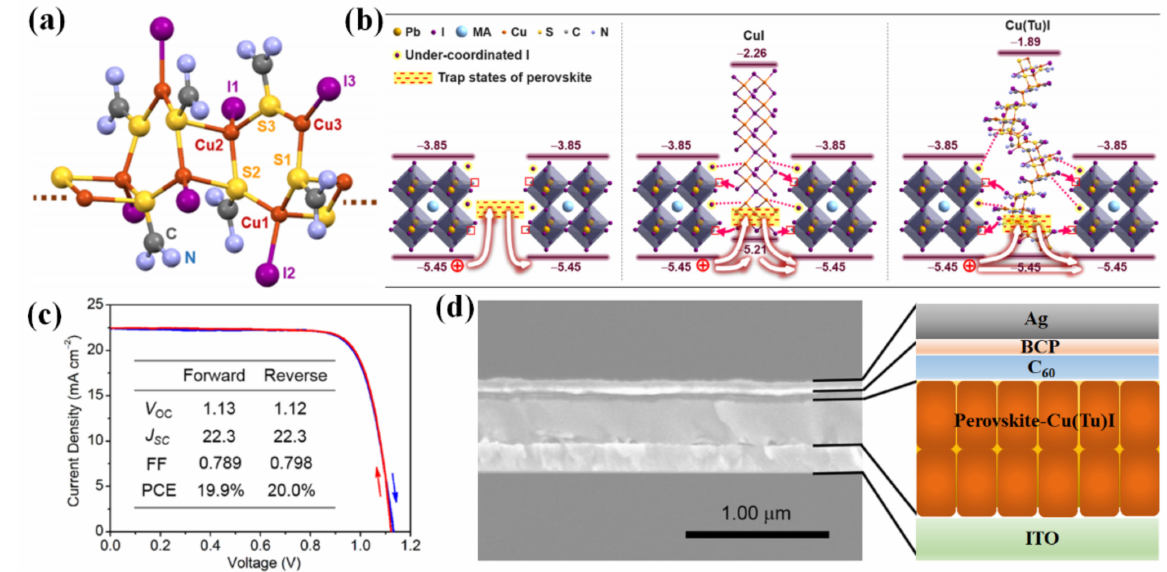
Figure 5. ( a ) Crystal texture of Cu(Tu)I [163]; ( b ) Sketch map of probable cause for the trap state sup- pression [163]; ( c ) Greatest J − V graph of inverted devices on the basis of Cu(Tu)I [163]; ( d ) Sectional view and device structure of inverted PSCs